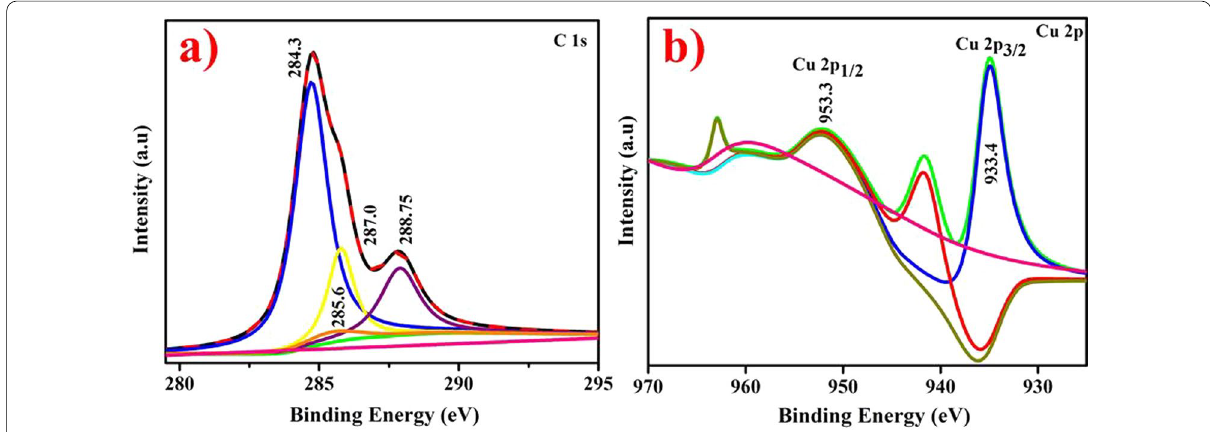
Fig. 8 a , b XPS analysis of doped CuO NPs a C1s b Cu